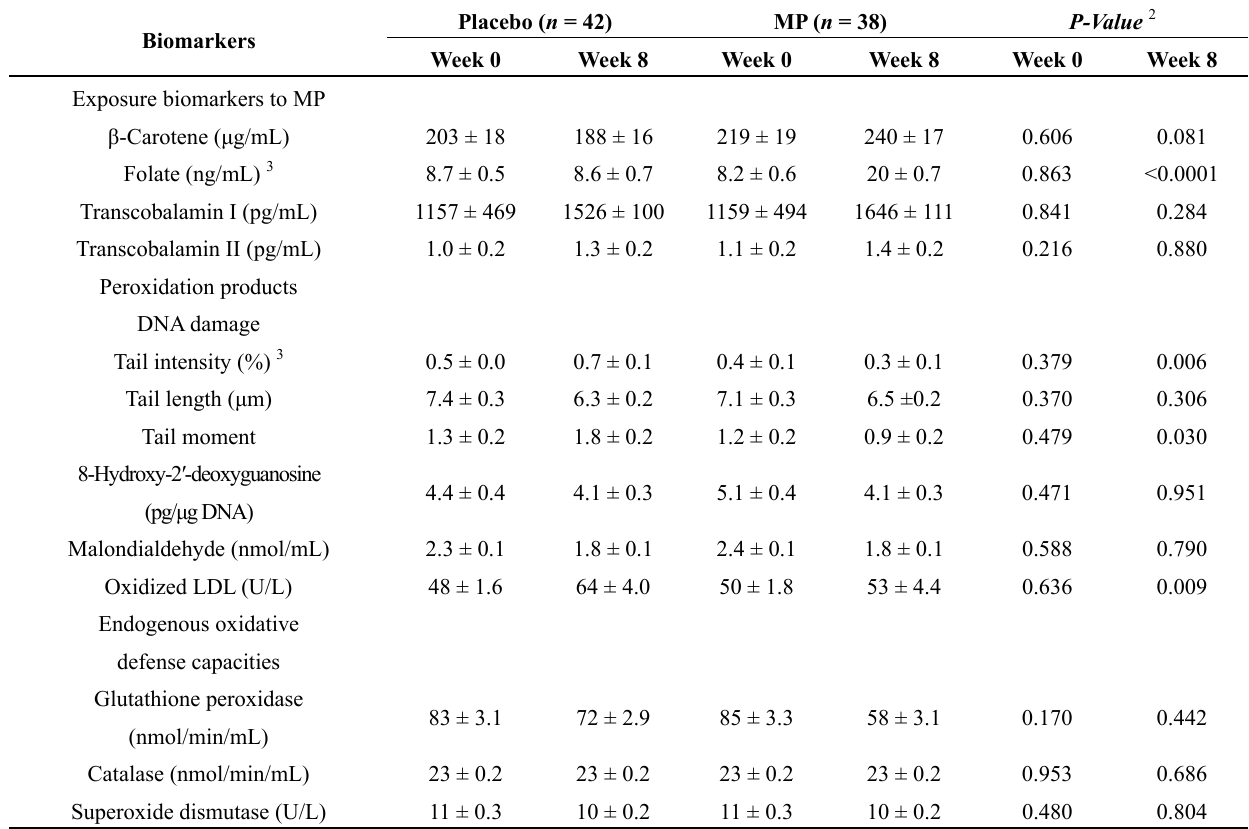
Table 3. Summary of oxidative stress biomarkers at baseline and after the eight-week intervention 1